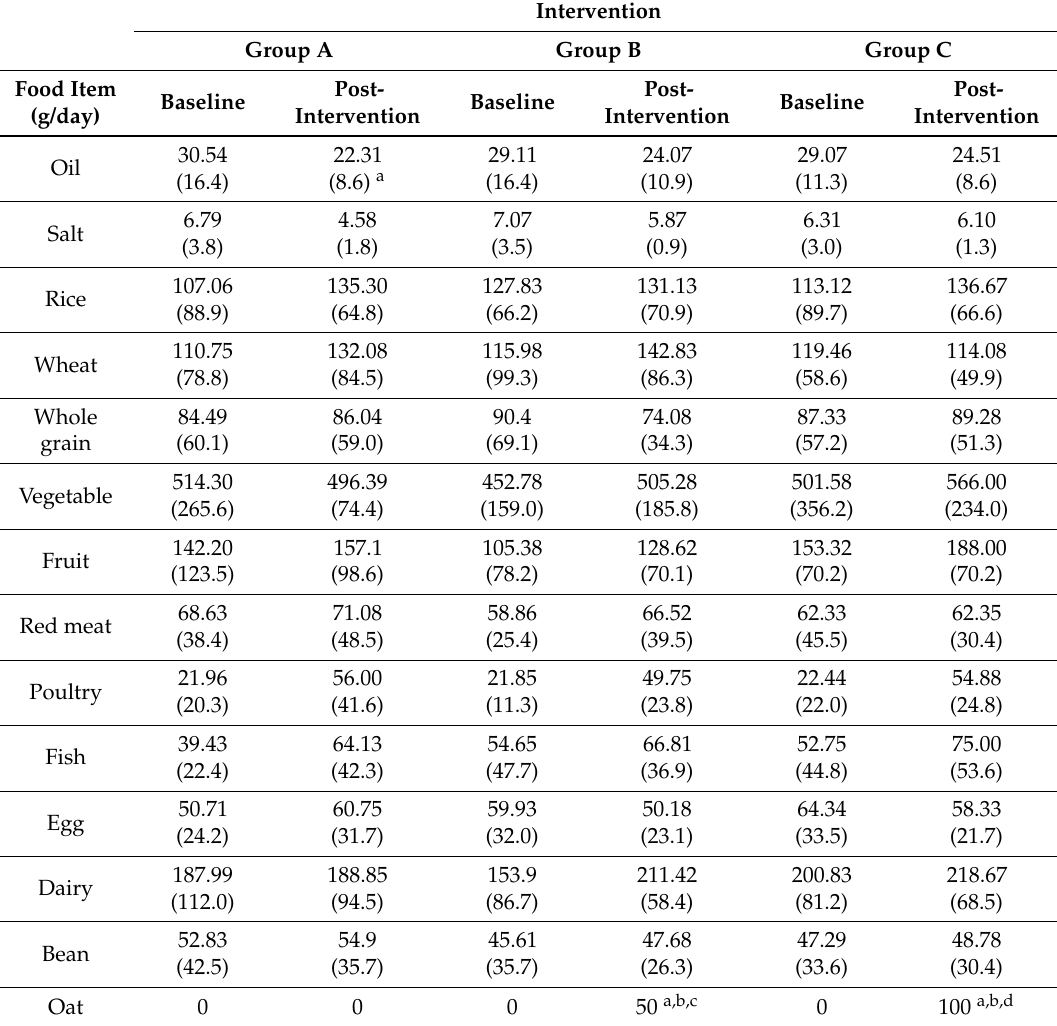
Table 1. Food items in each food category during pre- to post-intervention among the different